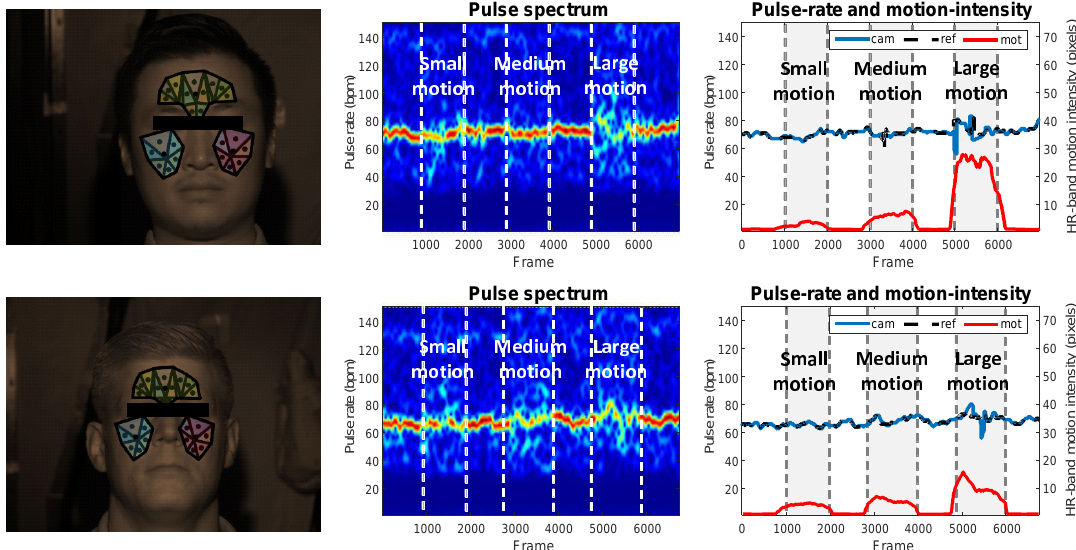
Figure 11. Exemplified measurements obtained by the processing flowchart with the DIS algorithm. From left to right: video frames showing the measured skin areas, pulse spectrogram, and pulse-rate and motion-intensity traces. The x-axis denotes the frame number (time axis); the left y-axis denotes the pulse rate (frequency axis); and the right y-axis denotes the HR-band motion intensity (pixel axis). The reference PPG-rate is denoted by the dashed black line. The motion periods are indicated by gray padding. The HR-band motion intensity is denoted by the red line (to indicate the significance of